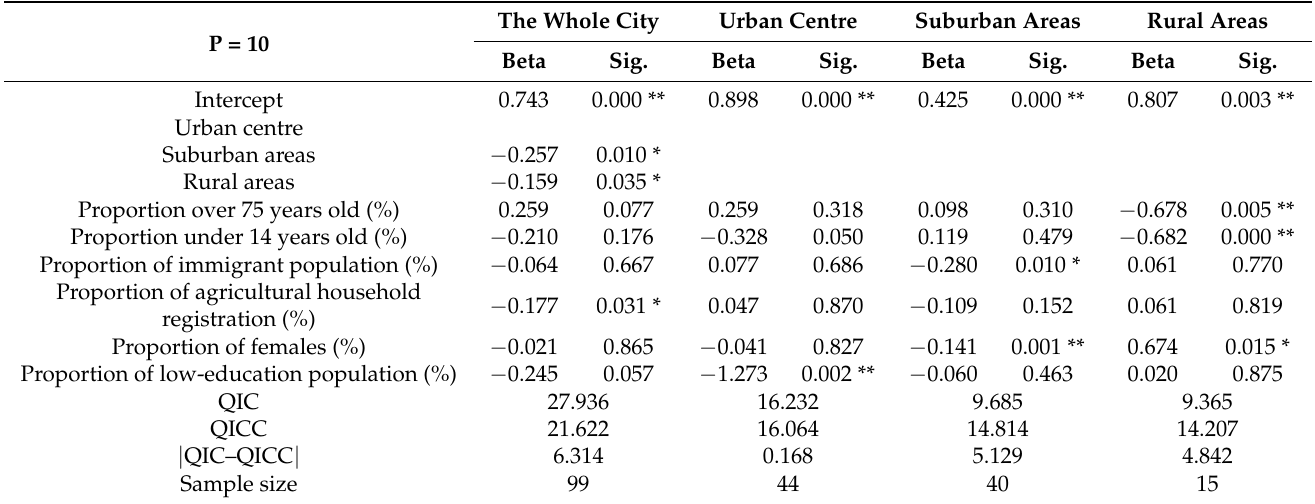
Table 4. GEEs for predicting the area of the flooded proportion over 10 years with respect to the vulnerable groups. P =